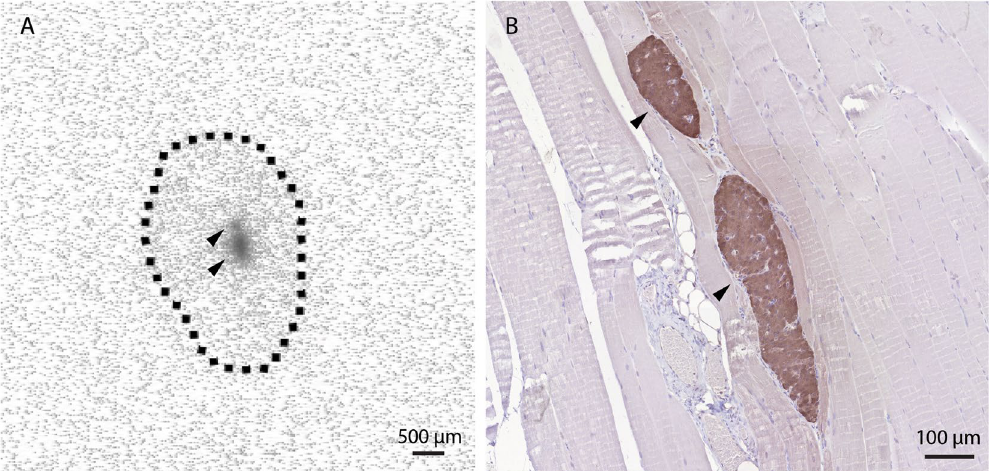
Figure 1. 111 In-exendin-3 uptake in the skeletal muscle is co-localized with islet transplants. ( A ) Autoradiography of muscle sections shows local accumulation of 111 In-exendin-3 (black arrows), the limits of the muscle section are shown by the dashed line. ( B ) Immunostaining of the corresponding autoradiography section shows co-localization between beta-cells (brown) and 111